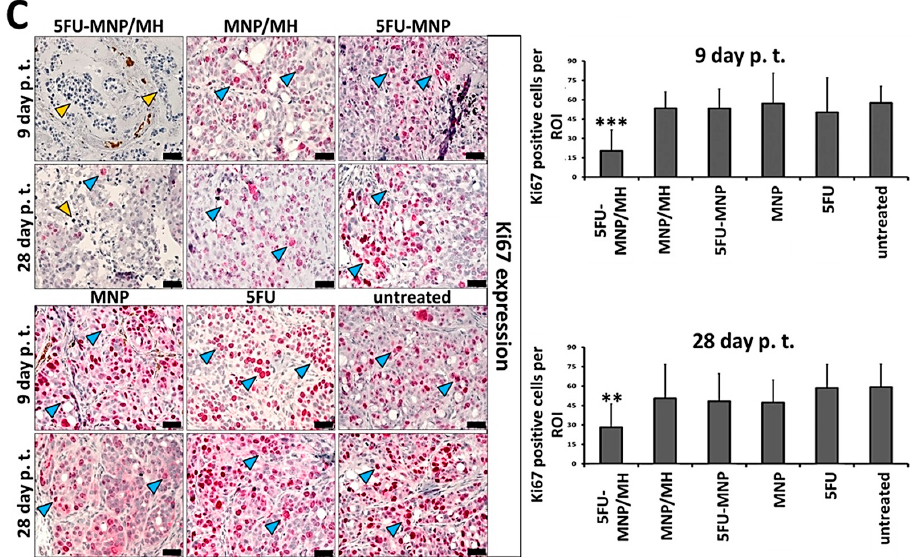
Figure 2. The combinatorial thermo-chemotherapeutic tumor treatment resulted in a significant tumor volume reduction (* p < 0.05 for days 14 and 21 post first tumor therapy and ** p < 0.01 for days 7 and 28 post first tumor therapy) compared to all other treatments. ( a ) Development of tumor volume over time in the combinatorial treatment (5FU-MNP / MH; 60 min at H = 15.4 kA / m, f = 410 kHz) and control groups. Tumor volume in percentage was calculated relative to the tumor volume on day − 3 post first tumor therapy. ( b ) Representative photographs of tumors in each group during therapy. ( c ) Reduction of Ki67 expression in tumors treated with the combinatorial therapy (5FU-MNP / MH) compared to the either therapies alone (5FU-MNP or MH). Depicted are representative histological micrographs of tumor tissue slices after immunohistochemical staining as well as semi-quantitative estimations of protein expression (three independent ex vivo experiments). Yellow arrows mark representative nuclei of proliferative cells and blue arrows mark representative non-proliferative cells. Scale bar = 40 µ m for histological images. Bars represent mean ± standard deviation ( n ≥ 10 animals per group and n = 16 for Ki67 expression analysis). MH: magnetic hyperthermia; MNP; magnetic nanoparticle; 5FU: 5-fluorouracil; p.t.; post injection. Mann–Whitney U-Test and independent two-sample t-test indicated significant di ff erences between the hyperthermia and chemotherapy combination (5FU-MNP / MH) group and the hyperthermia (MNP / MH) group with other groups (* p < 0.05, ** p < 0.01, and *** p <